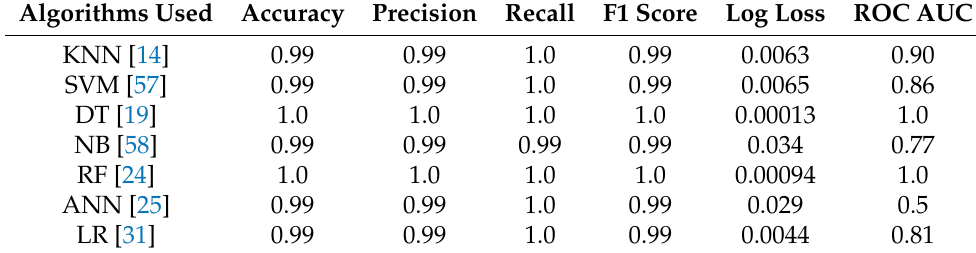
Table 31. DoS HTTP results.